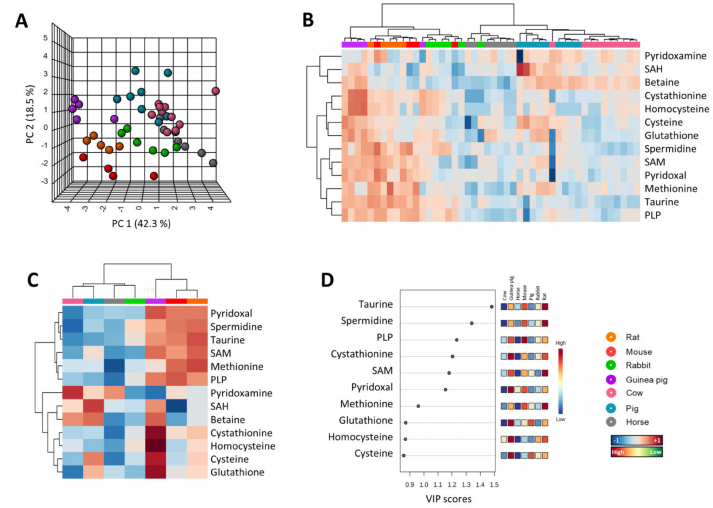
Figure 1. Multivariate statistics reveal a specific methionine heart profile for mammals. ( A ) Principal component analyses (PCA) representation of methionine-related metabolites. X: Principal compo- nent 1 (PC1); Y: Principal component 2 (PC2); Z: Principal component 3 (PC3). PC3 = 10.1% (not shown). ( B ) Hierarchical clustering of individual animal samples according to metabolite abundance. ( C ) Hierarchical clustering of animal species according to average metabolite abundance. ( D ) Variable importance projection (VIP) scores indicating the elements which contribute most to defining the first component of a partial least squares discriminant analysis (PLS-DA).